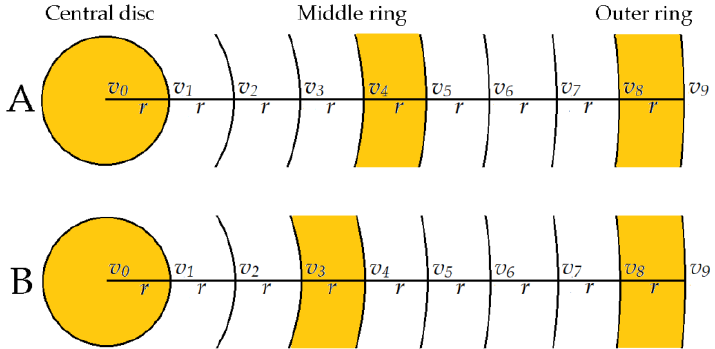
Figure 1. Two finite dimensions model (FDM) based tripolar concentric ring electrodes (TCREs) configurations: constant inter-ring distances (CIRD) ( A ) and linearly increasing inter-ring distances (LIIRD) ( B ).